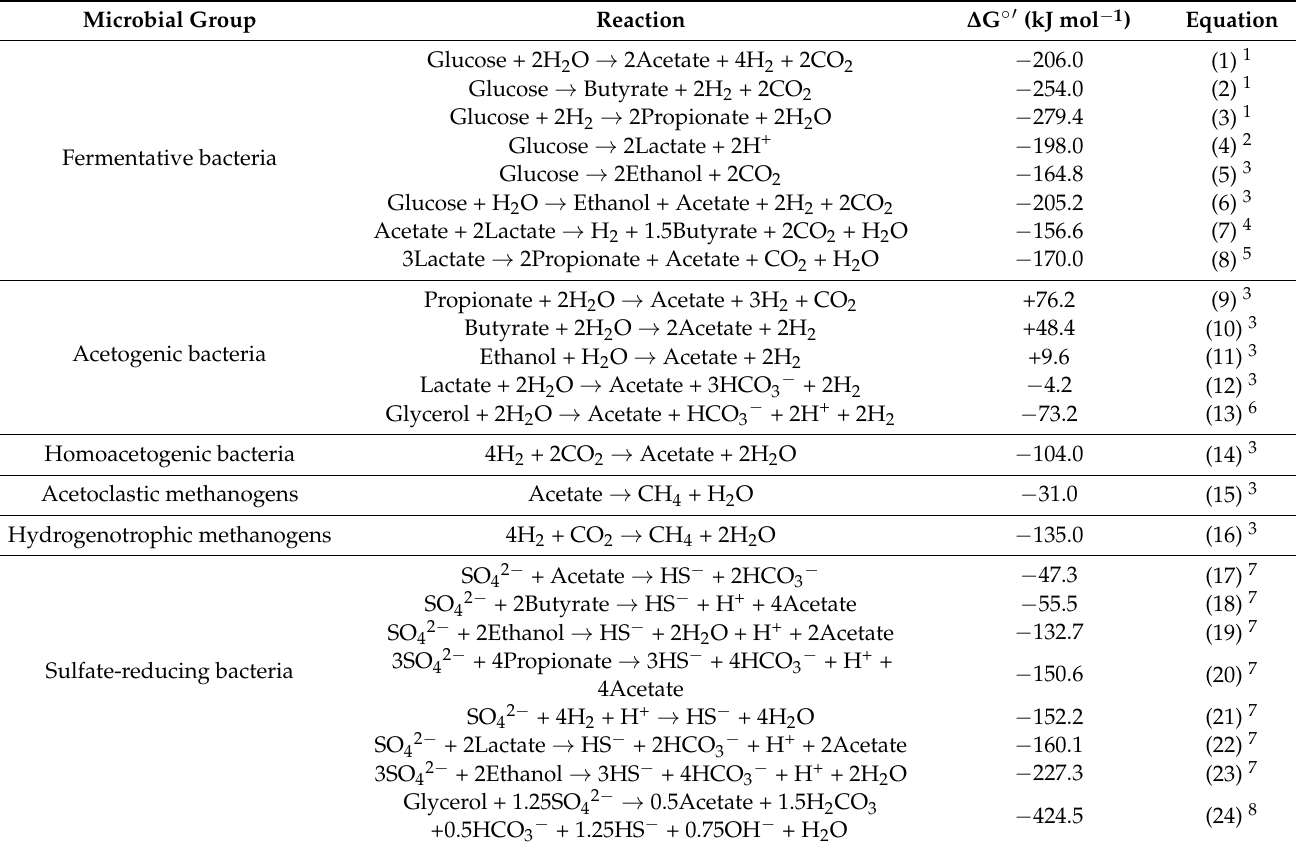
Table 1. Biochemical reactions performed by different microbial populations in anaerobic environ- ments and the respective Gibbs free